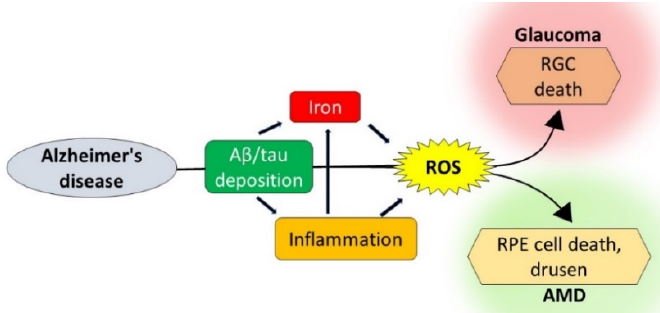
Figure 1. Pathogenic pathways shared by Alzheimer’s disease (AD), AMD, and glaucoma: AD-associated amyloid β (Aβ) and tau deposits lead to inflammation and iron accumulation, increasing ROS. Aβ, hyper-phosphorylated tau (p-tau), inflammation, and ROS together lead to RGC death typical of glaucoma and retinal pigment epithelial (RPE) dysfunction associated with AMD. ROS: reactive oxygen species, RGC: retinal ganglion cells, and AMD: age-related macular